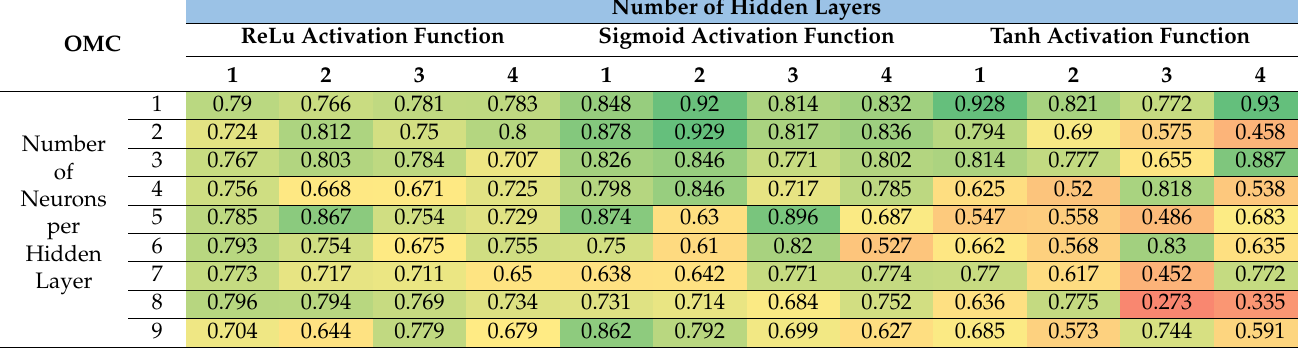
Table 3. R 2 values of the testing set for every ANN in the prediction of the